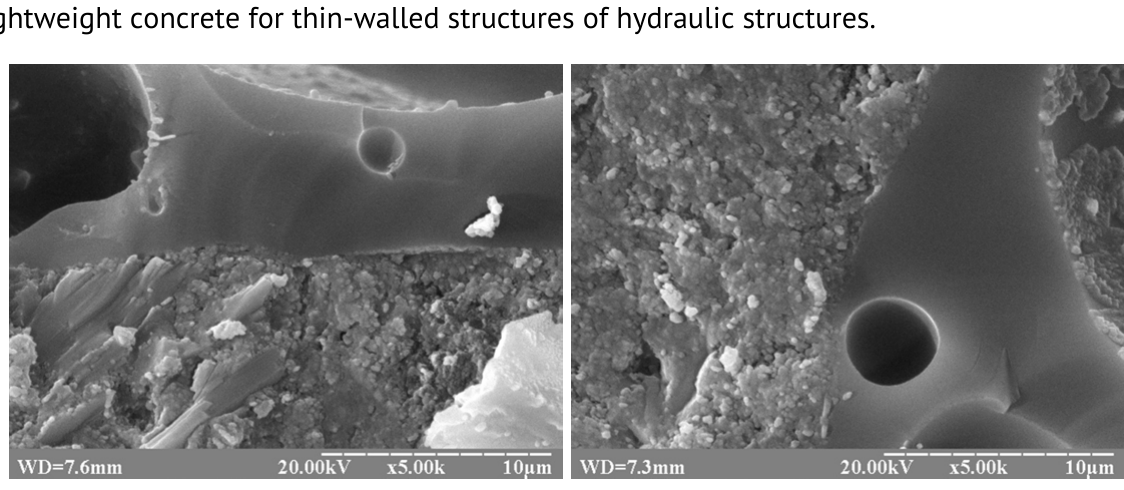
Figure5. The structure of the contact zone of foam glass granules and cement- sand matrix, an increase of